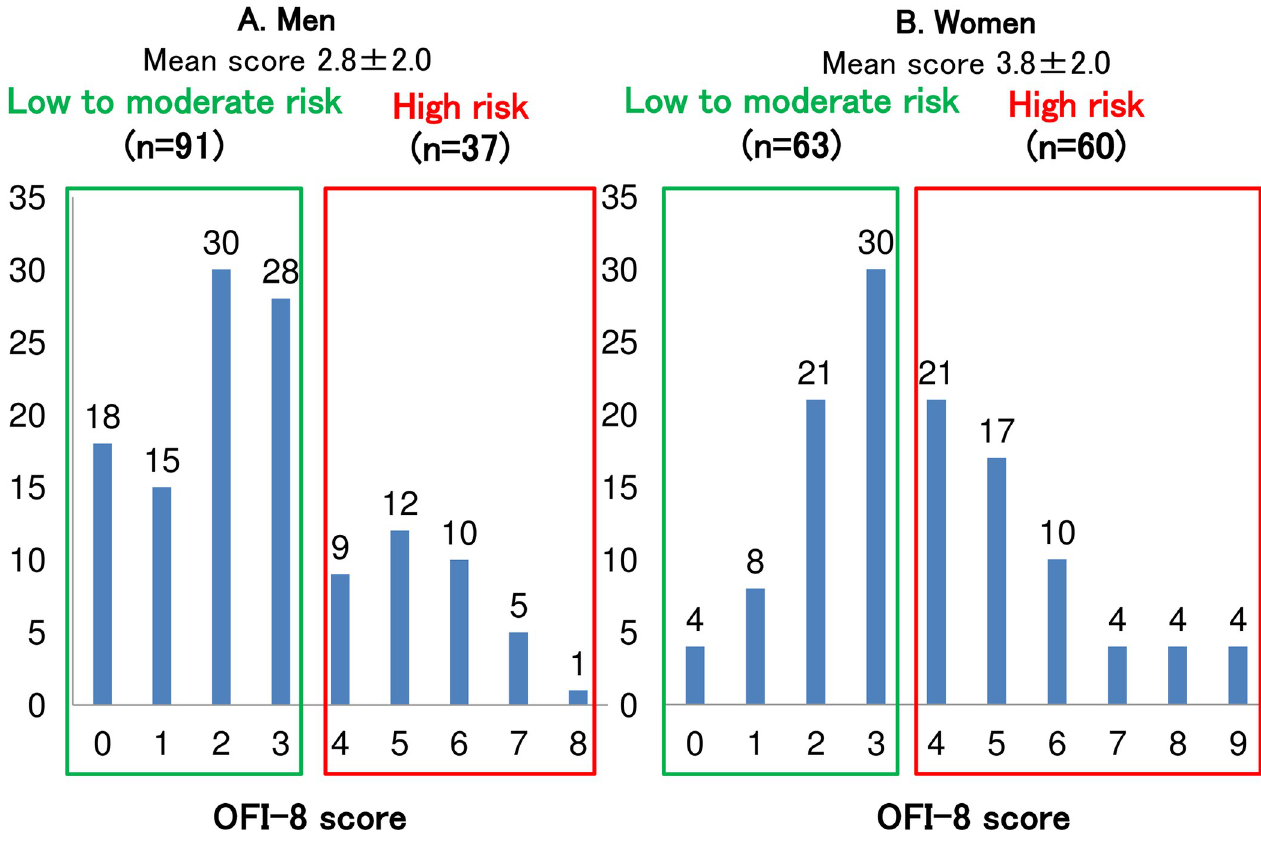
Fig 1. Distribution of OFI-8 scores in men (A) and women